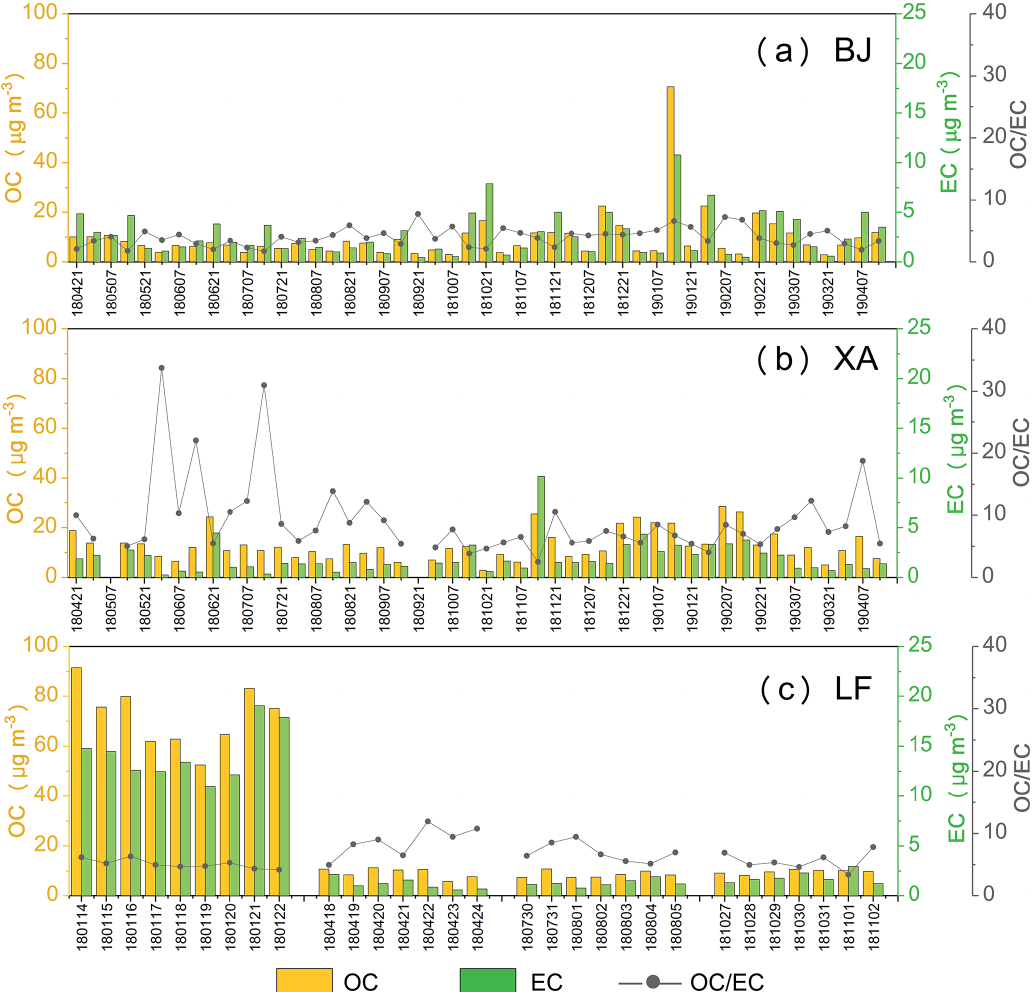
Figure 2. Variations of elemental carbon (EC), organic carbon (OC), and their ratios in PM 2 . 5 at the sampling sites in BJ, XA, and LF (date,